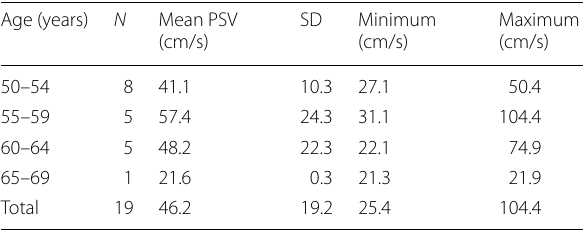
Table 3 Frequency distribution of the patients with venogenic ED and their respective cavernosal artery PSV